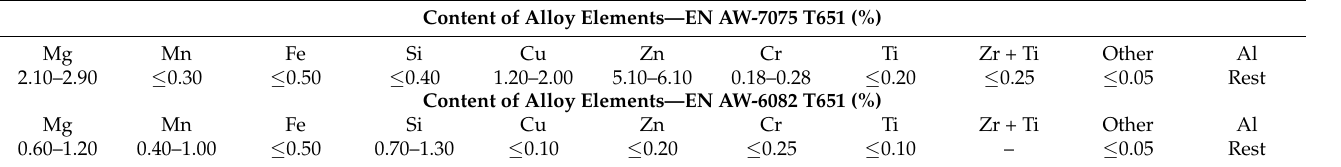
Table 1. The chemical composition of EN AW-7075 T651 and EN AW-6082 T651 aluminium alloys (own elaboration, based on